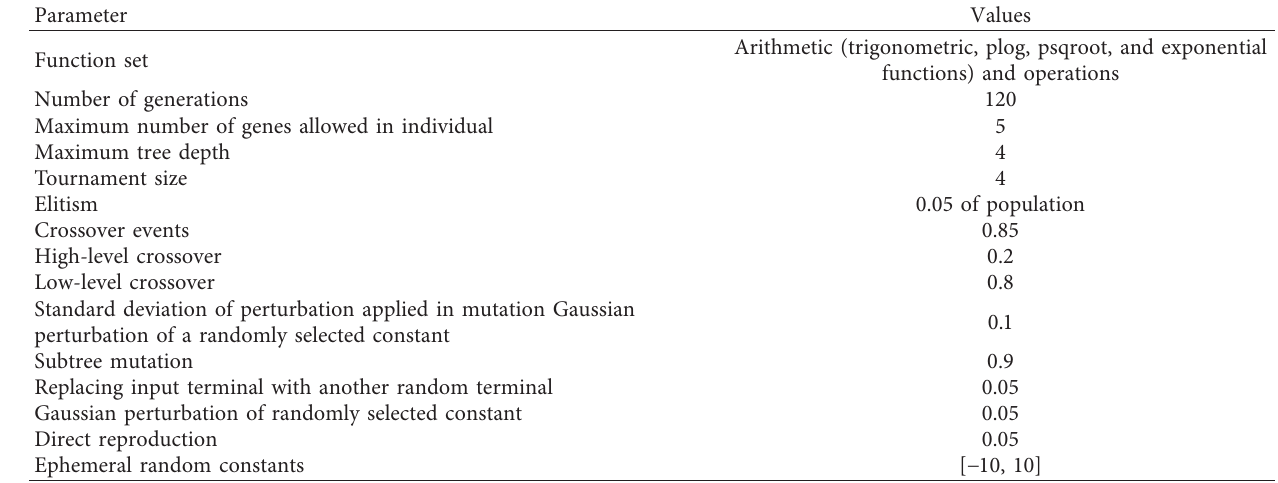
Table 2: Values of MGGP controlling